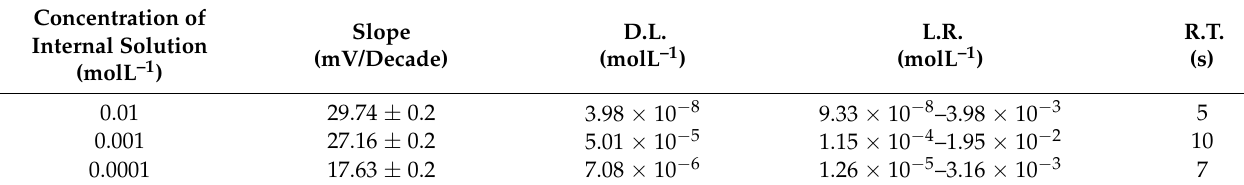
Table 2. The influence of internal solution concentration on the potential of the optimized Hg 2+ –SE. Concentration of